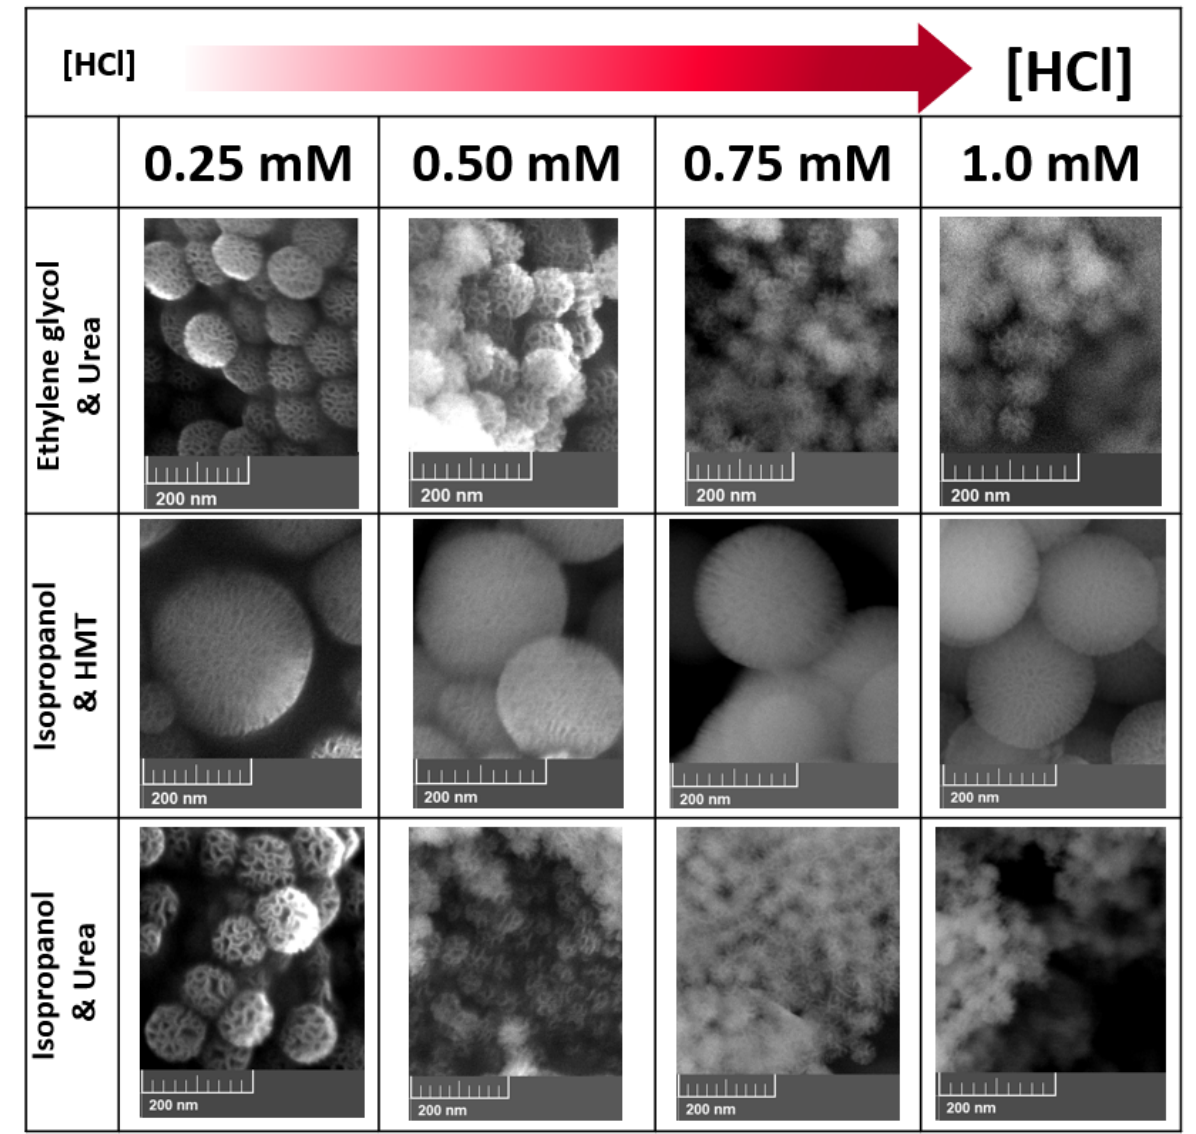
Figure 2. WMS typical homogeneity and size dispersion as seen by SEM for different synthesis performed using varying co-solvents and bases in the presence of distinct concentrations of HCl.